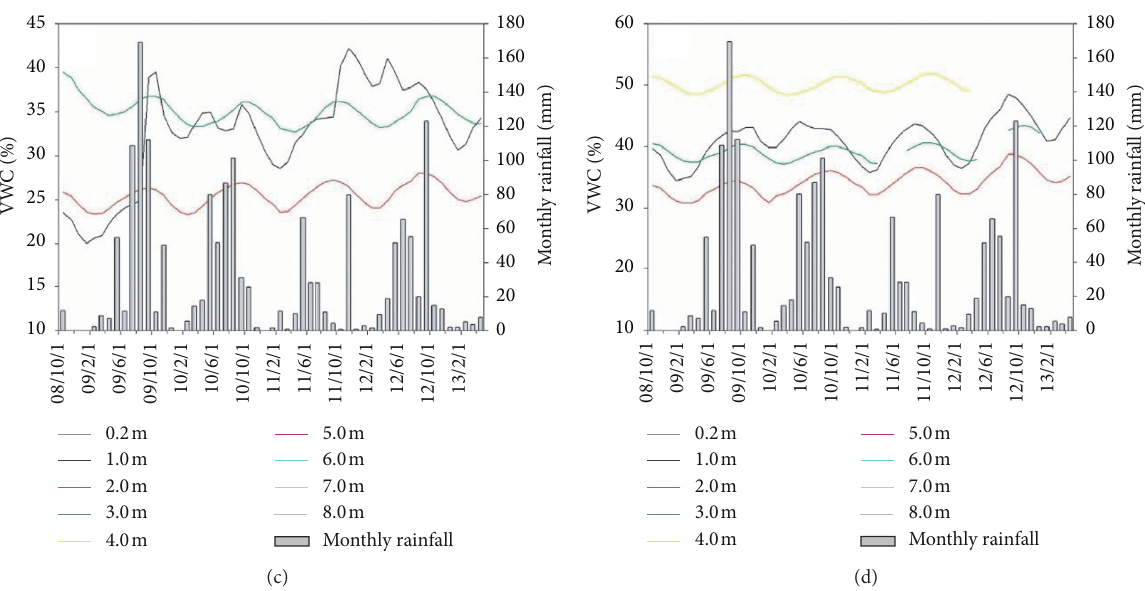
Figure 6: Relationship between monthly soil VWC and rainfall: (a) TDR1; (b) TDR2; (c) TDR3; (d)